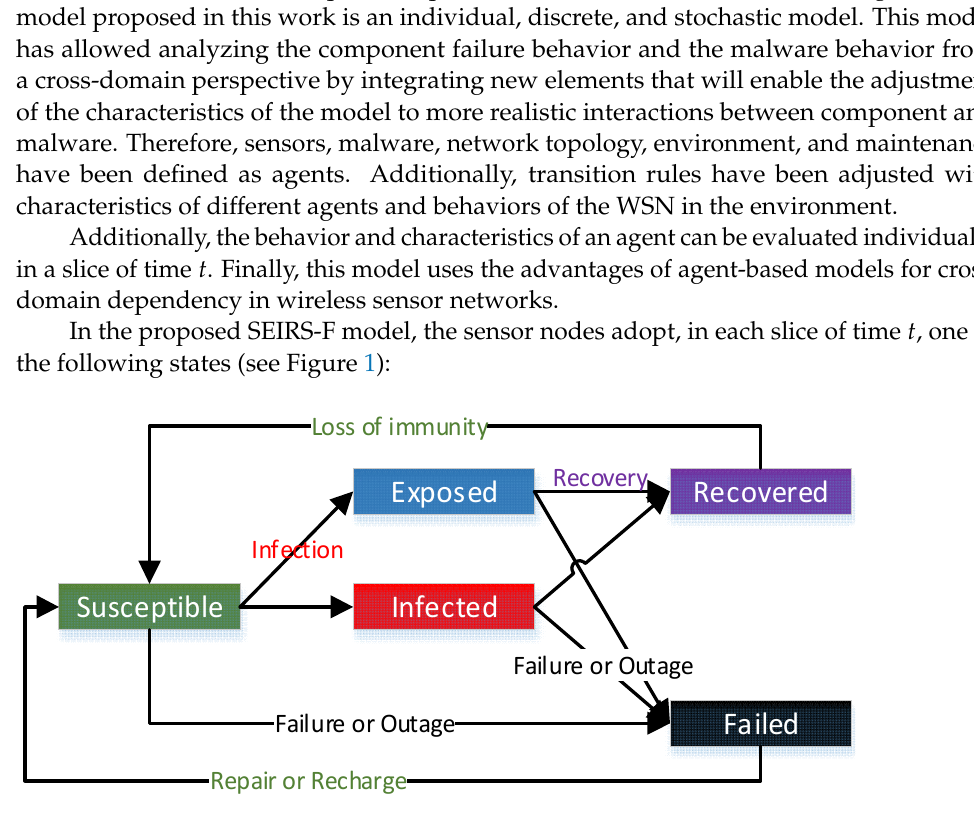
Figure 1. Scheme of the SEIRS-F model.